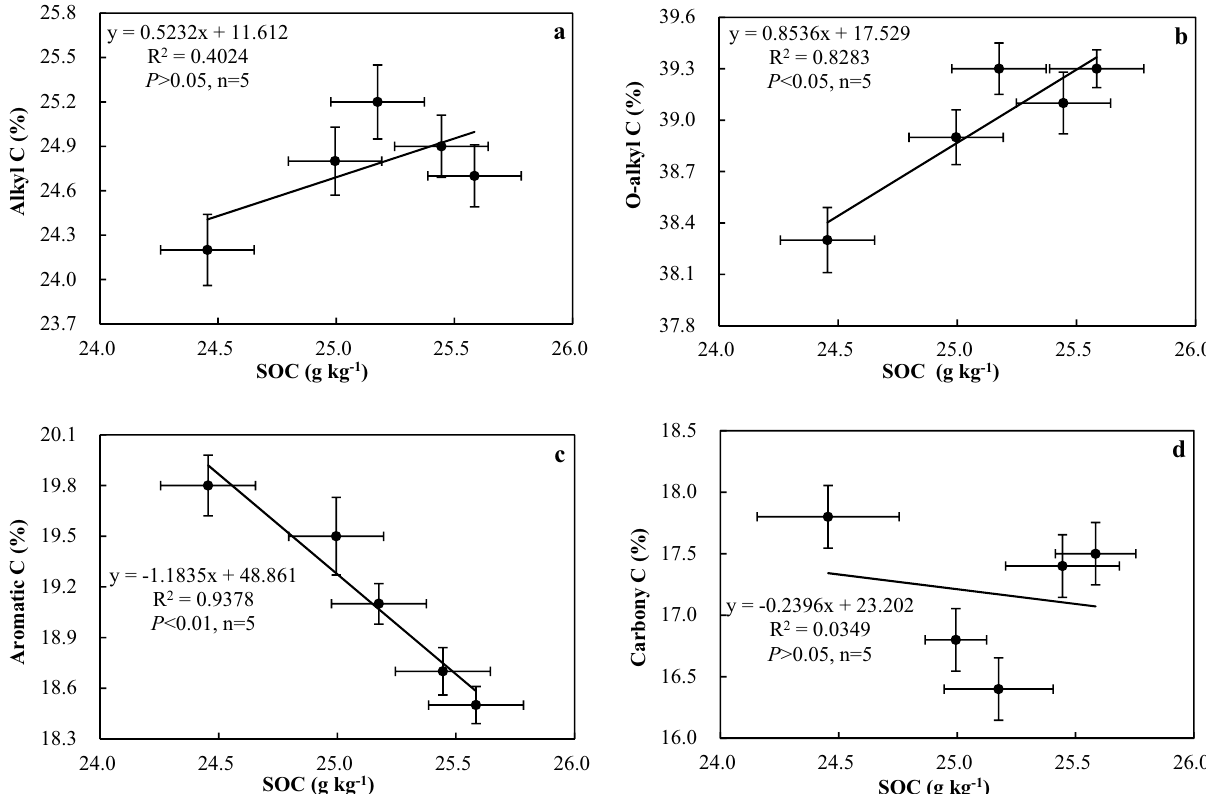
Figure 3. Correlation between soil organic carbon content, clay content, and relative proportion of organic carbon functional